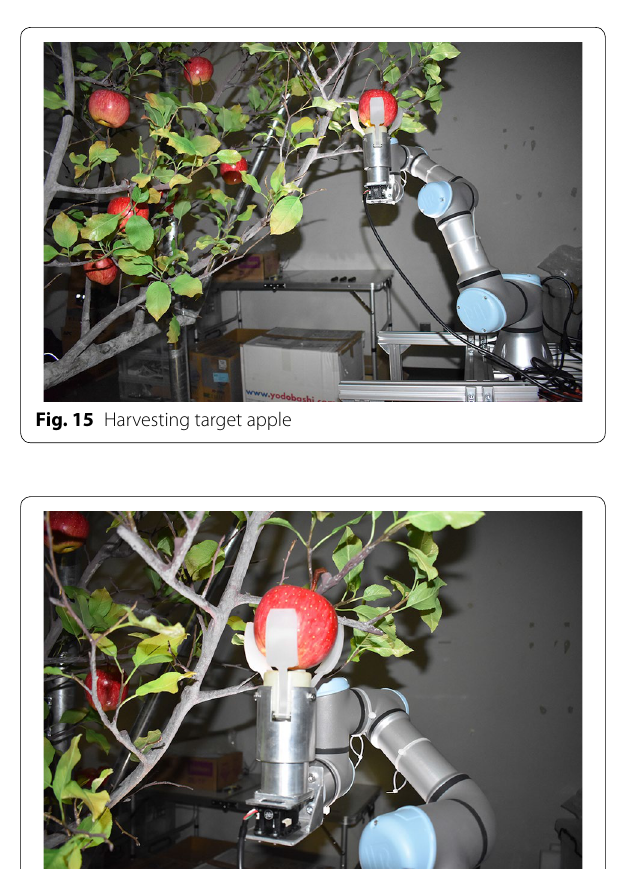
Fig. 16 Grasping target